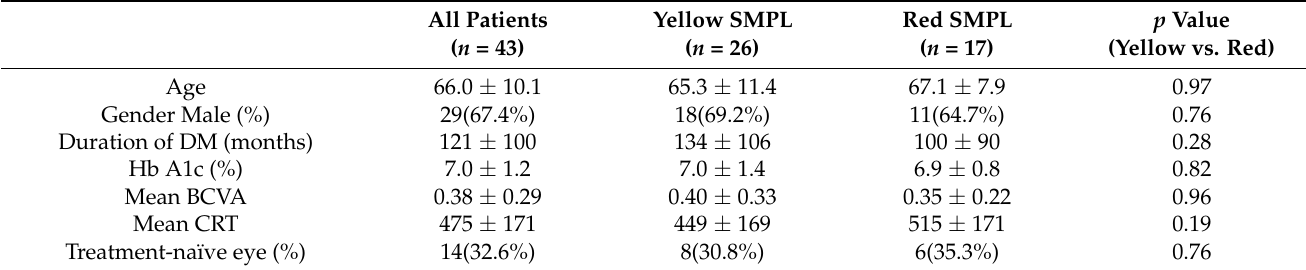
Table 1. Baseline characteristics of the patients and a comparison of those in the yellow and red SMPL groups. All Patients